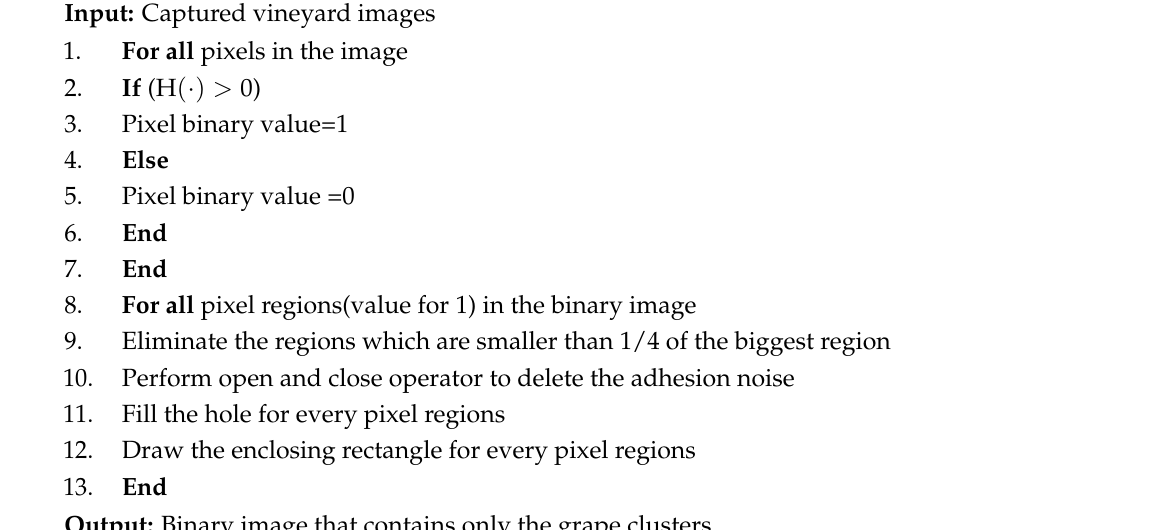
Algorithm 2. The pseudo code of image segmentation and targets extraction.